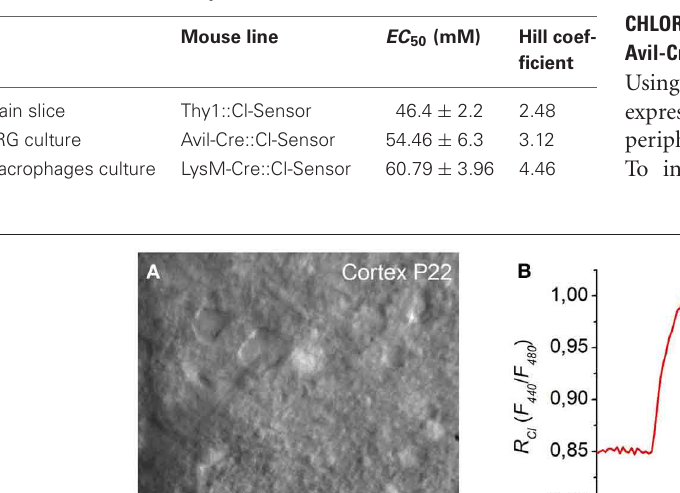
increase in the R Cl . (C) Monitoring of epileptic-like seizures in neurons of brain slice from cortex (P22). Traces of R Cl changes from two neurons are illustrated upon application of 100 μ M 4-AP. The neuron corresponding to the red trace was patched with a pipette containing 135mM Cl, while the blue trace corresponds to the record from intact neurons. Note that 4-AP application caused a stronger increase in R Cl than depolarization from − 70 to +